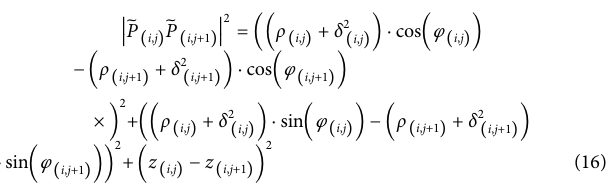
Frontiers in Materials |